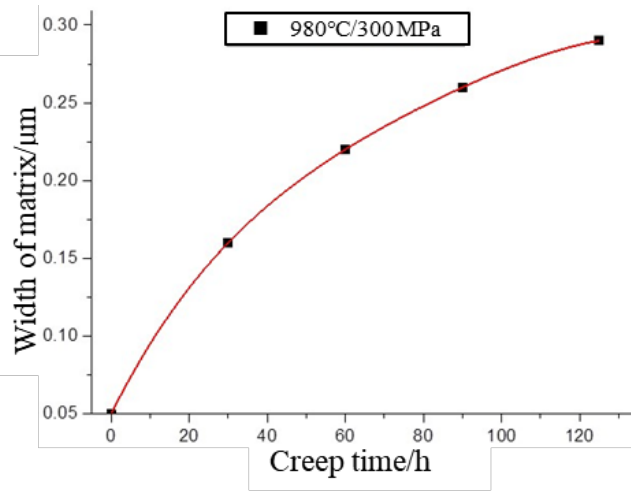
◦ C/300 MPa. Figure 10. Variation of matrix phase channel width at 980 °C/300 MPa.